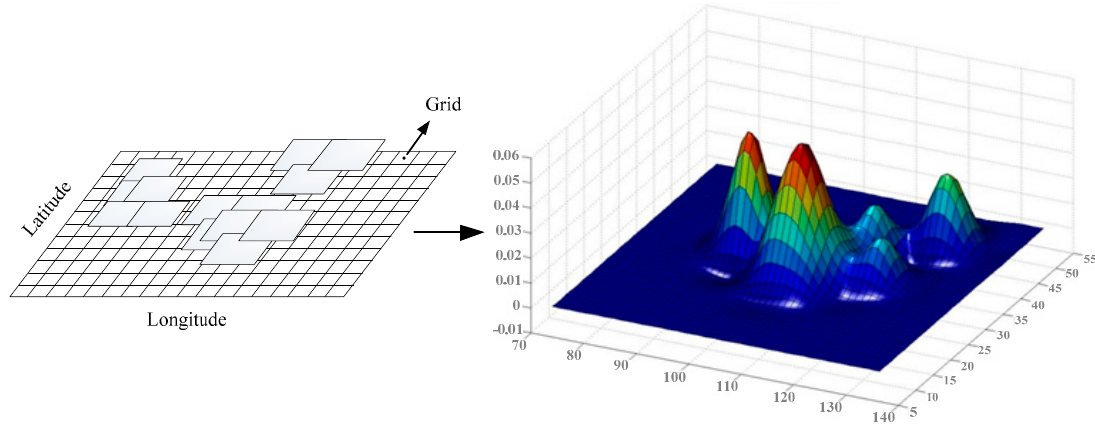
Figure 2. The distribution of location preference.